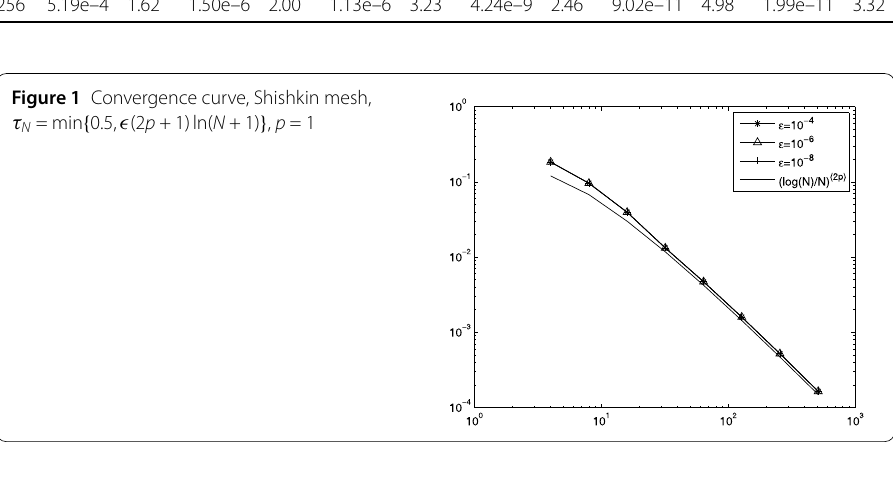
Figure 2 Convergence curve, Shishkin mesh,